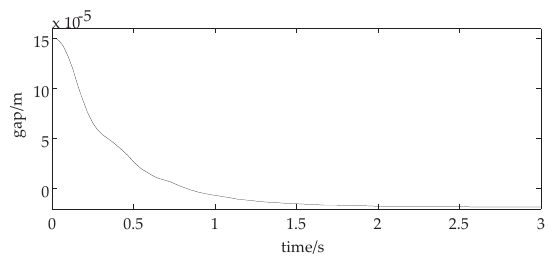
Figure 2. The suspension displacement curve with stable suspension.